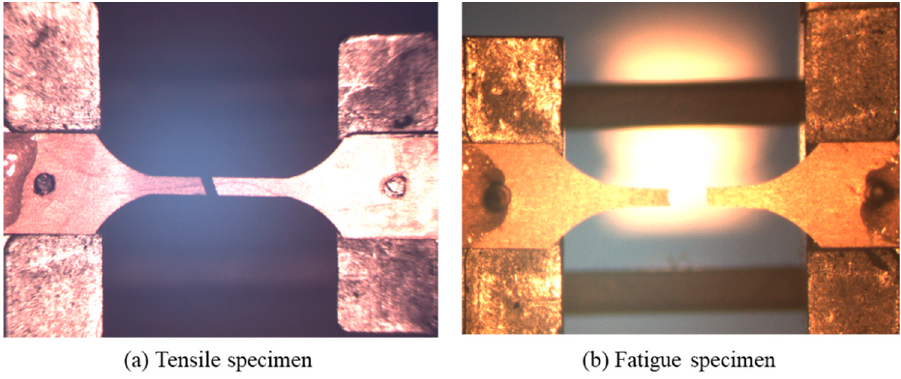
Figure 6. The fracture images of specimen when alignment is correct.